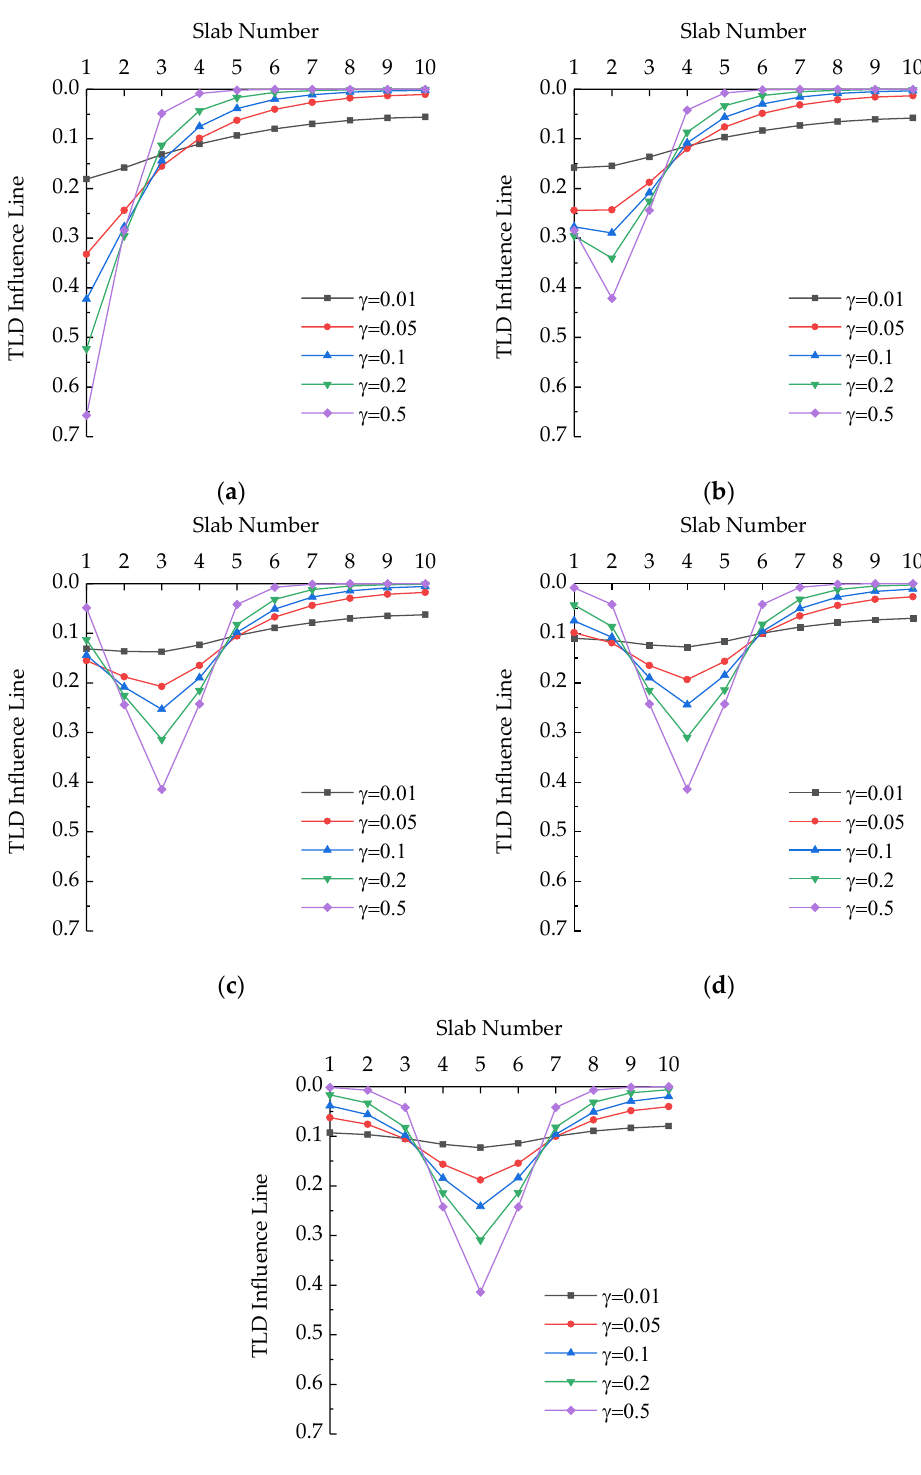
Figure 16. The peak values of influence lines of TLD for each slab at different relative stiffness. 7. Conclusions (1) In this paper, the TMM is provided for calculating the influence line of TLD of articulated slab bridges. The field transfer matrix and transfer equation of each slab are developed, and the TLD of each slab is calculated by very simple matrix operations. The method avoids the large linear equations of bridge structures, which has a highly efficient algorithm and is easy for implementation in hand calculations, spreadsheets, or small computer programs. (2) A transversely prefabricated void slab bridge is taken as an example, and FEM and FM are used to verify the method in this paper. The calculation results are very close, with maximum errors lower than 10%, thus proving the correctness and feasibility of the proposed method. In addition, TMM can capture variations in TLD along the bridge span compared with FM, which further proves the wide applicability of TMM. (3) Under constant cross-sections and transverse quantities of slabs, the force on each slab under the load becomes more uniform as the span of the bridge became larger. The peak value of the influence line of TLD for each slab showed a non-linear decrease with the increase of the span-width ratio, and the decrease rate of exterior slabs is larger than that of interior slabs. In the design of transversely prefabricated slab bridges, a more